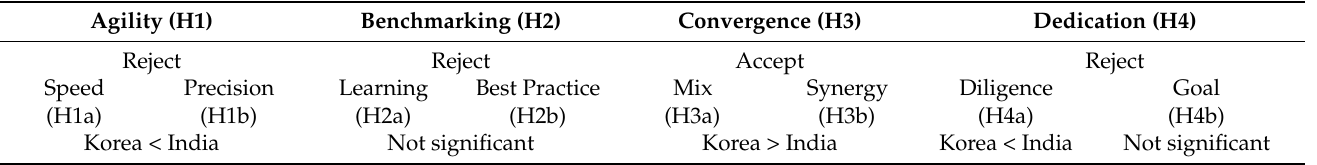
Table 4. Summary of hypotheses testing.